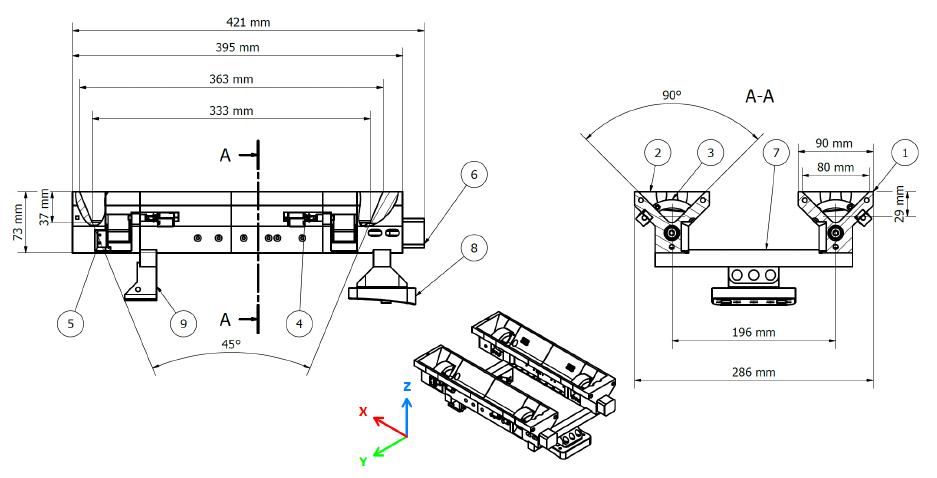
Figure 7. The dimensions and components of the landing platform for the Shafter drone: 1—left V-rail, 2—right V-rail, 3—locking clamp, 4—door-lock-style solenoid, 5—end stop, 6—stepper motor NEMA14, 7—aluminum profile frame, 8—rear Spot mount plate, 9—front Spot T-slot